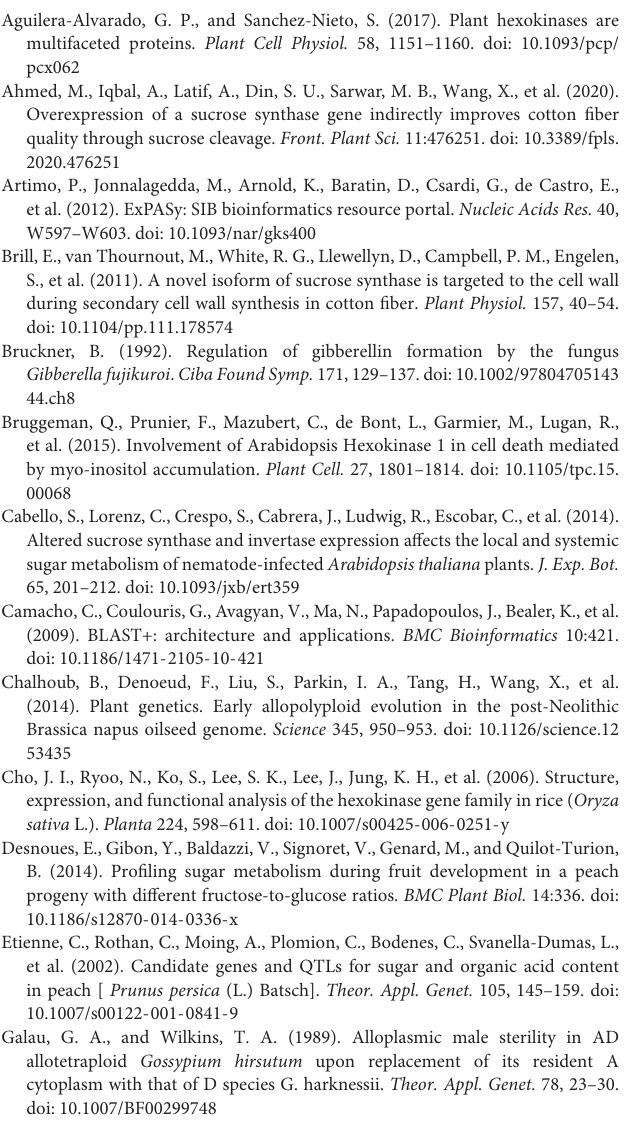
Supplementary Figure 1 | Chromosomal distribution of GaHXKs and GrHXKs . The arrows show the direction of the transcription of HXK genes. Supplementary Figure 2 | Chromosomal distribution of GanHXKs, GstHXKs, GloHXKs , and GroHXKs . The arrows show the transcript direction of HXK genes. Supplementary Figure 3 | Phylogenetic relationships and gene structures of HXKs in cotton species. (A) Phylogenetic tree of HXKs from G. hirsutum L., G. arboreum , G. raimondii , G. anomalum , G. stocksii , G. longicalyx , and G. rotundifolium . The tree was constructed by MEGA 7.0 with default parameters